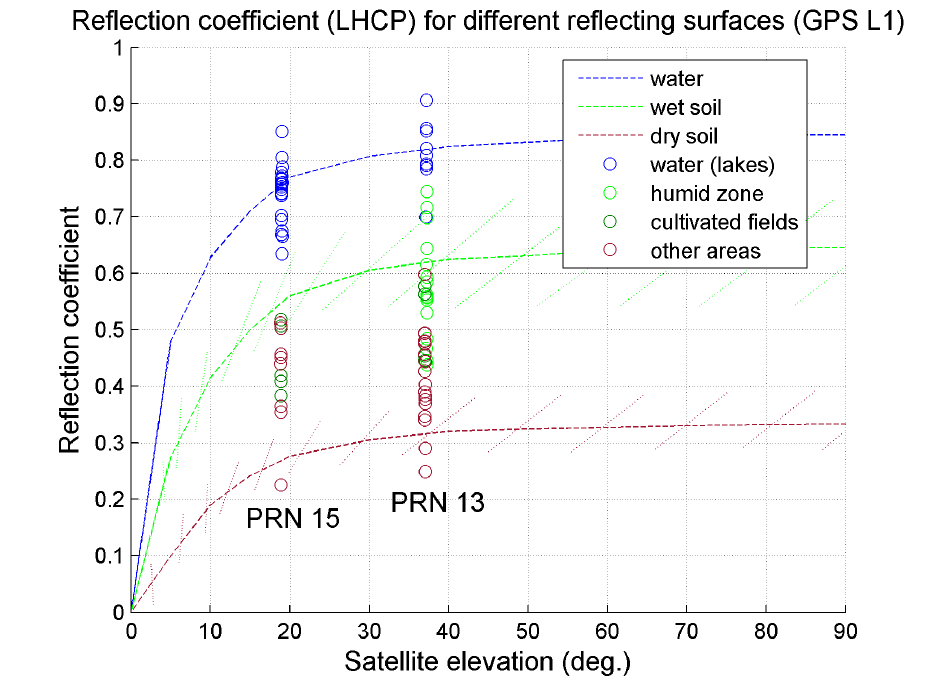
Figure 12. Reflection coefficient: comparison between expected and measured values, for different reflecting surfaces and satellite